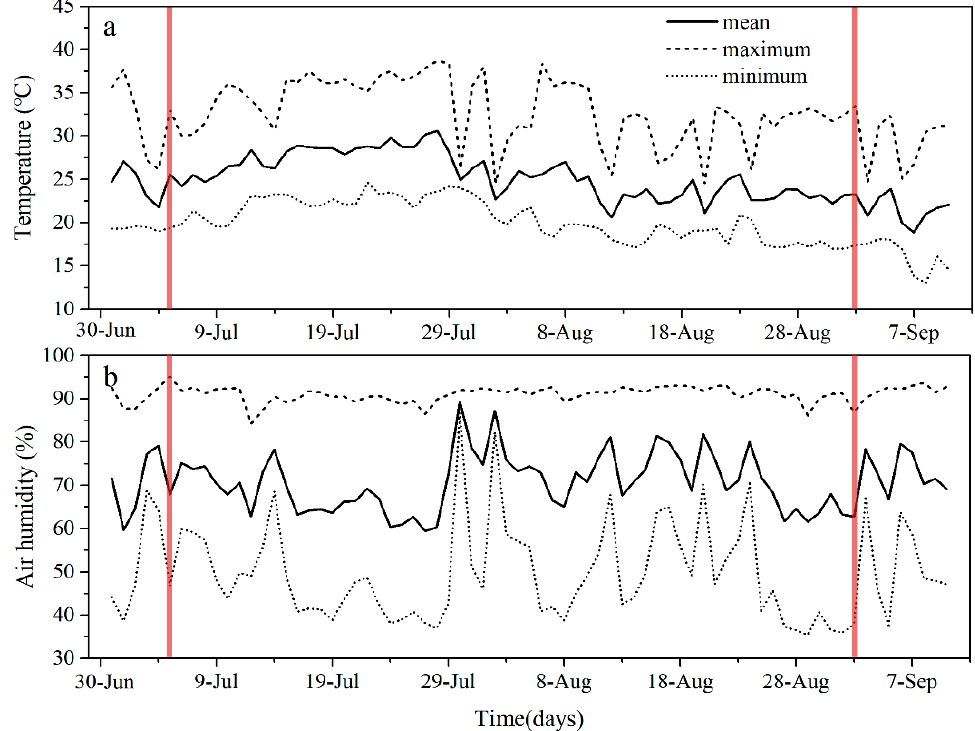
Figure 1. Daily mean, maximum, and minimum temperatures ( a ) and air humidity ( b ) measured over time during the whole experiment. The vertical red line shows the beginning and end of the drought period.